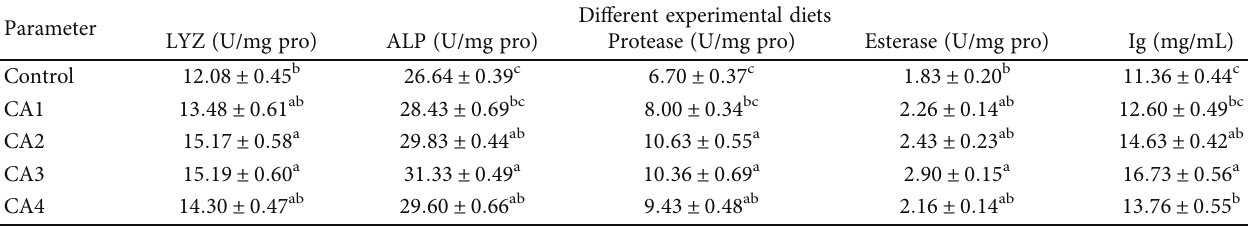
Di ff erent experimental